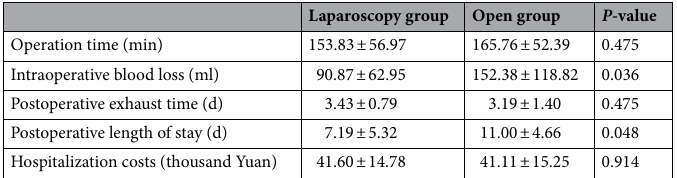
Table 3. Comparison of surgical-related indicators between the two